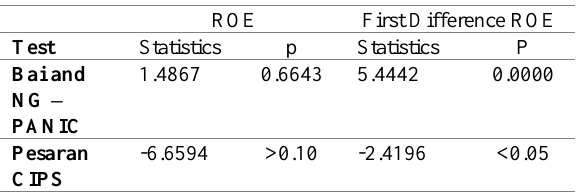
Table 14. Unit root test results of Model